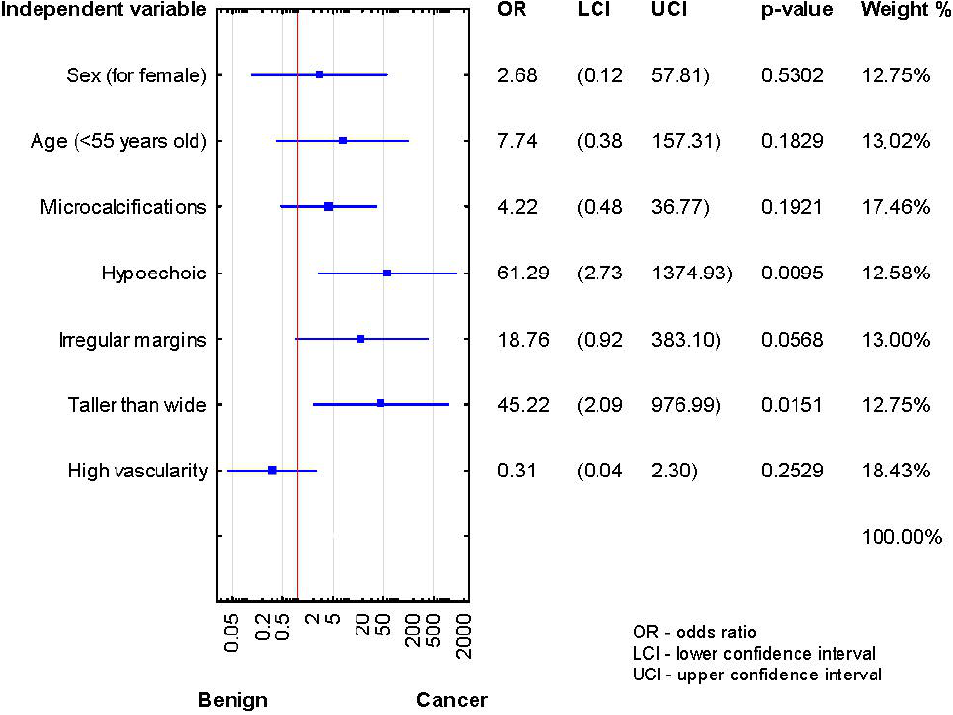
Figure 3. Forrest plot showing the odds ratios for cancer risk in the patients after the second diag- nosis of AUS/FLUS ( n =